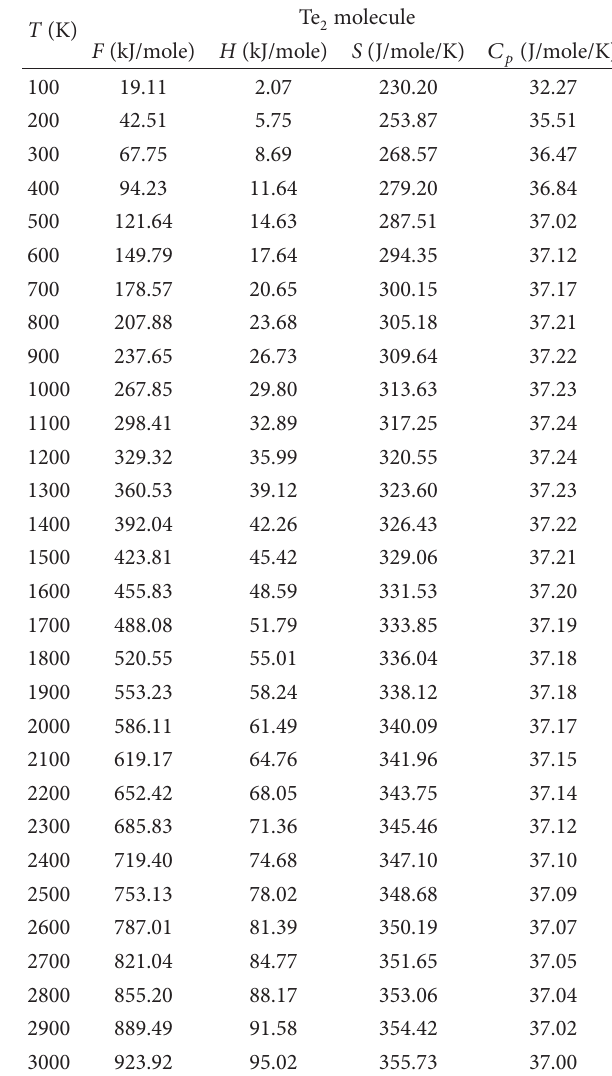
T 3: Calculated thermodynamical properties of